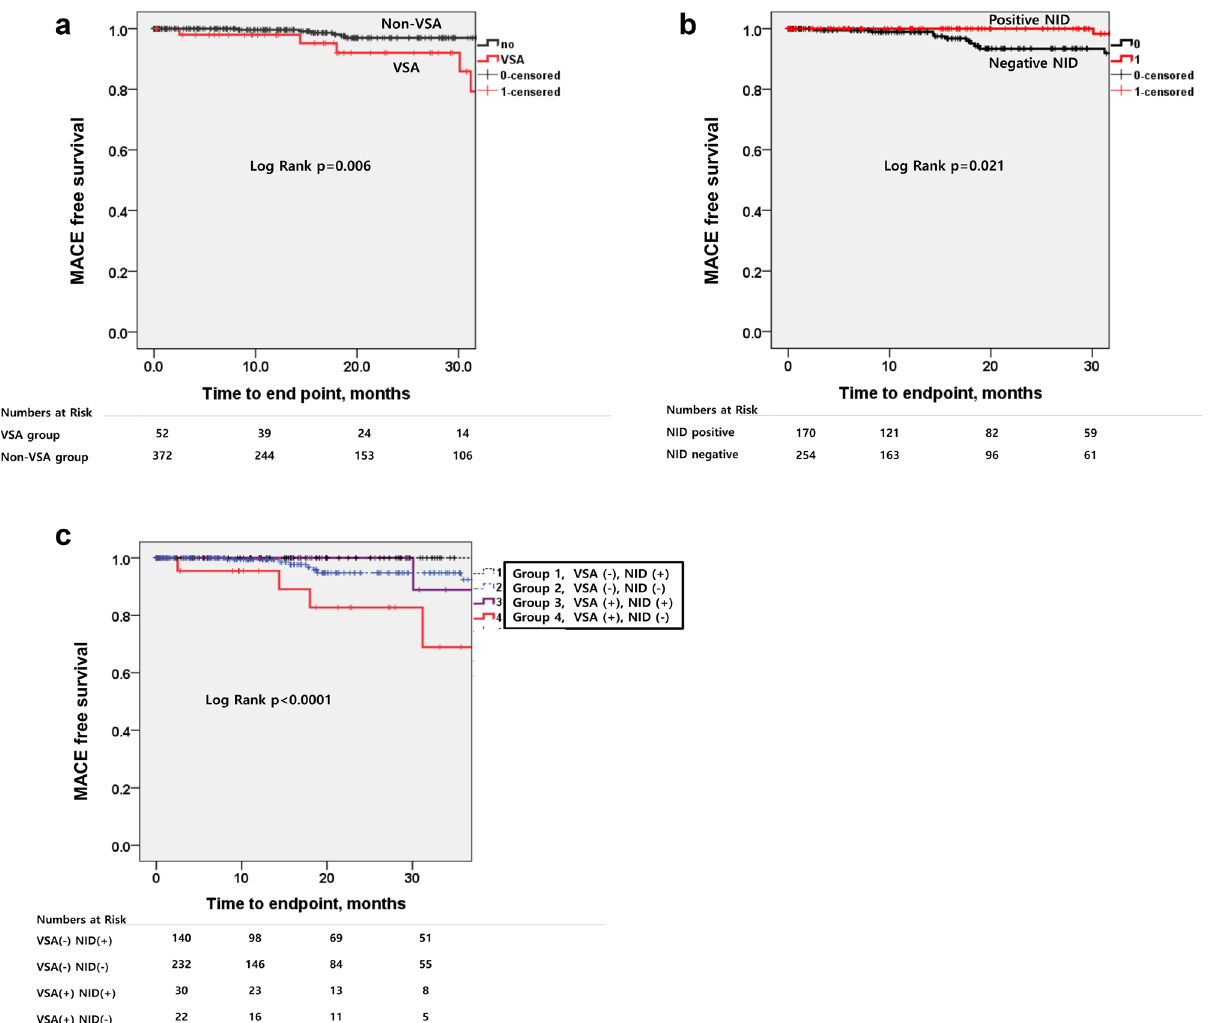
Figure 5. Kaplan–Meier survival curve analysis for the follow-up periods. ( a ) Kaplan–Meier survival curve in patients grouped according to the results of ergonovine provocation test. ( b ) Kaplan–Meier survival curve in patients grouped according to the results of NID. ( c ) Kaplan–Meier survival curve in patients grouped according to the results of ergonovine provocation test and NID. Abbreviations: MACE major adverse clinical events, VSA vasospastic angina, NID nitroglycerin induced